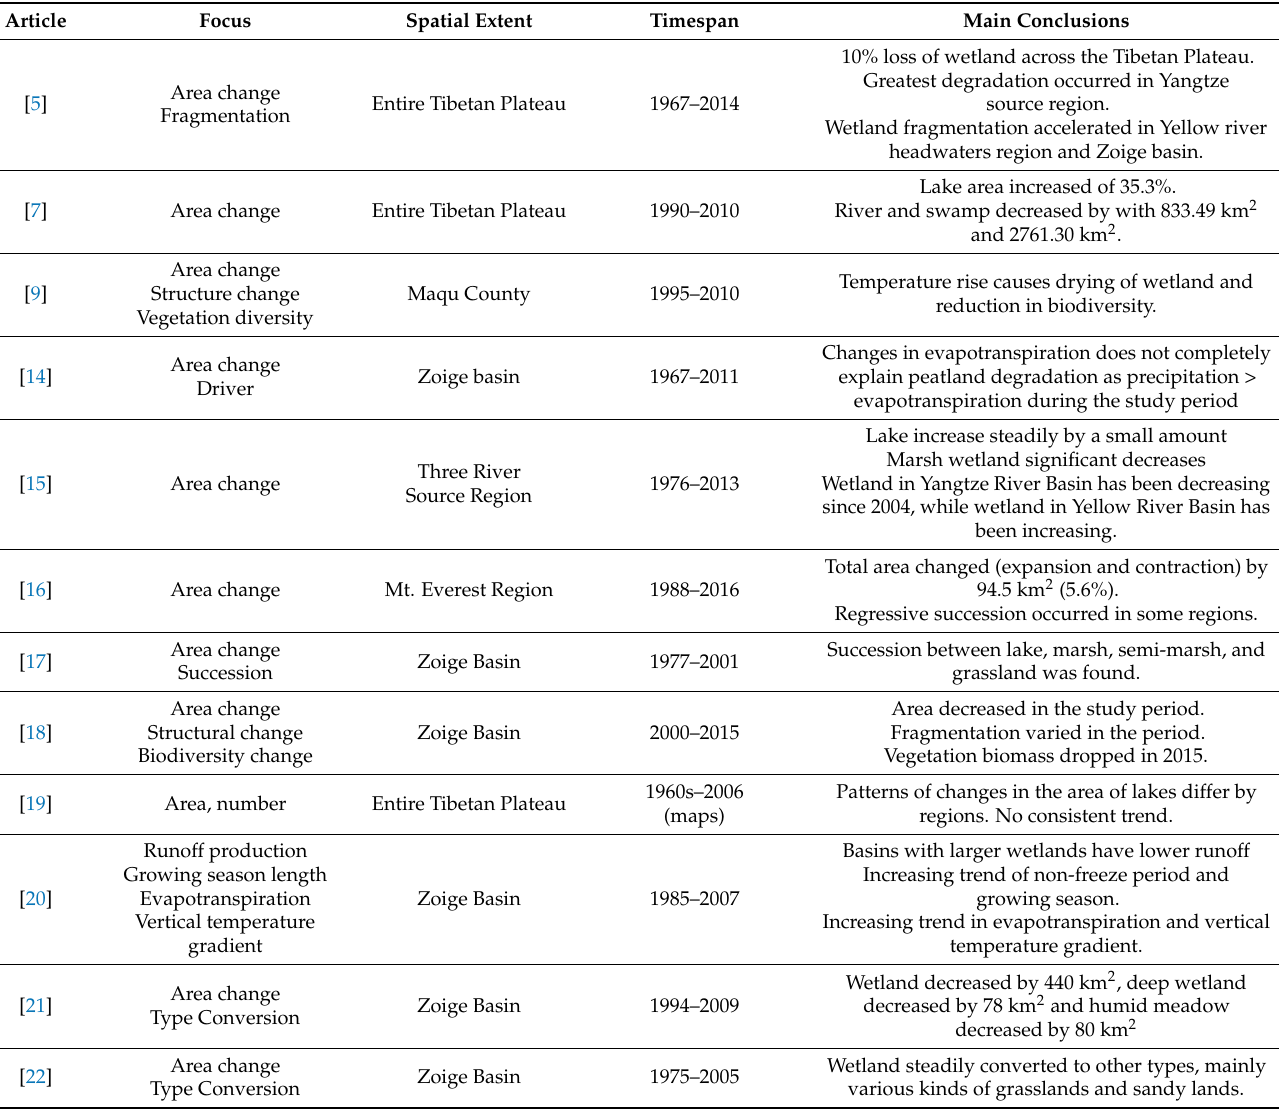
Table 1. A Sample of Studies on Wetland Change on the Tibetan